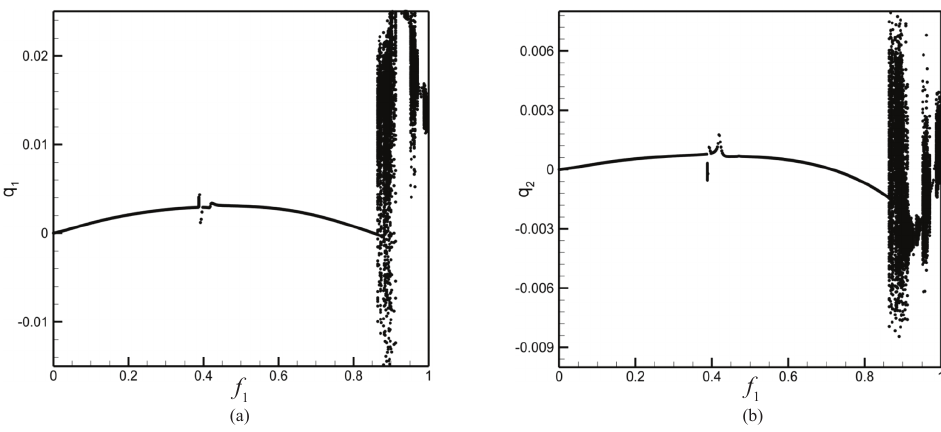
Fig. 15. Bifurcation diagrams of Poincaré points for increasing forcing amplitude on the system with γ T = 0 .